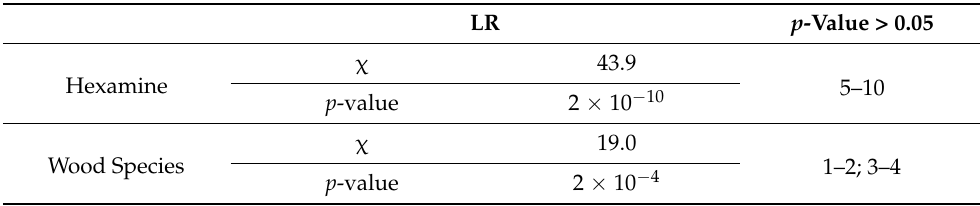
Figure 8. Leaching resistance of timber-impregnated samples in function of the concentration of hexamine. The symbol “ * ” indicates the outliers of the tests performed. Table 4. Kruskal and post hoc Dunn tests for leaching resistance as a function of wood species and amount of